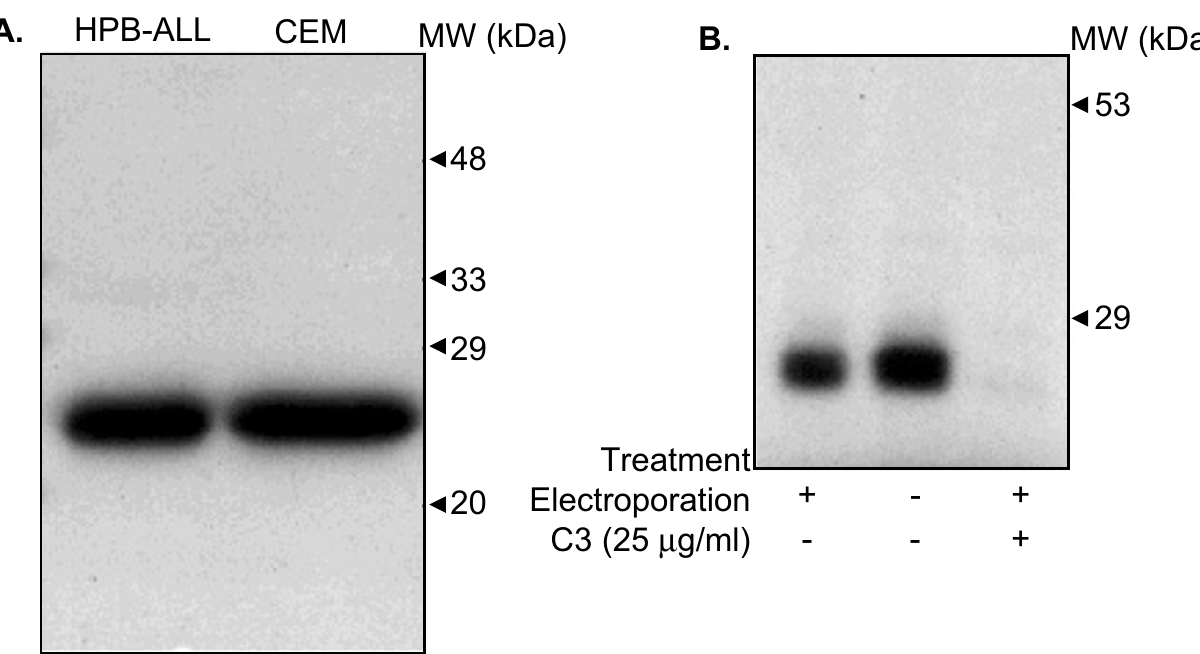
Figure 1 A. Western blot of RhoA protein in whole cell lysates of the T cell lines HPB-ALL and CEM. B. Electroporation of C3 efficiently ADP-ribosylates Rho in the T cell line HPB-ALL. Cells were untreated, electroporated in the presence of C3 (25 µ g/ml), or electroporated in control buffer. After a 1 hr incubation at 37°C, cells were further ADP-ribosylated as described in Experi- mental Procedures by the addition of exogenous C3 and [ 32 P]-NAD after cell